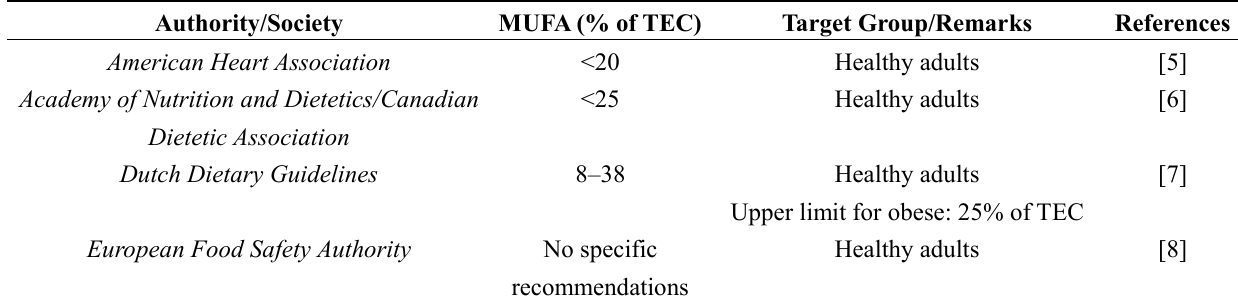
Table 3 summarizes MUFA recommendations of national and international authorities and organizations. Table 3. National and international MUFA recommendations for healthy adults and patients with